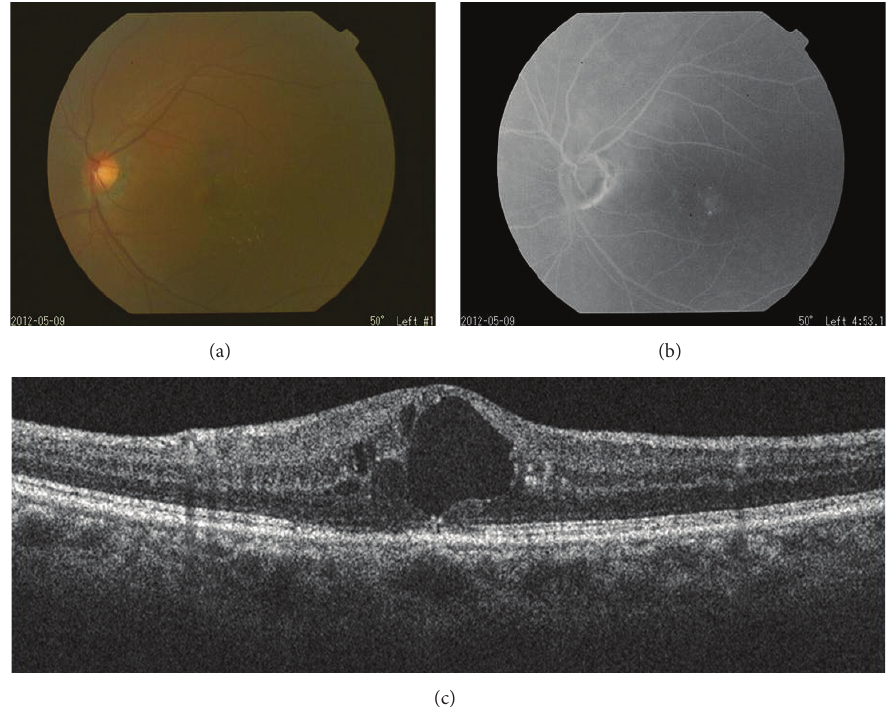
Figure 4: Findings of the left eye at the first visit of Case 2. The BCVA was 20/50. (a) Fundus photograph showed hard exudates associated with telangiectasia inferior temporal to the fovea. (b) Fluorescein angiogram showing fluorescein leakage in a circular pattern in the late phase. (c) Optical coherence tomographic image showed cystoid macular edema at the macula surrounded by circularly arranged fluorescein